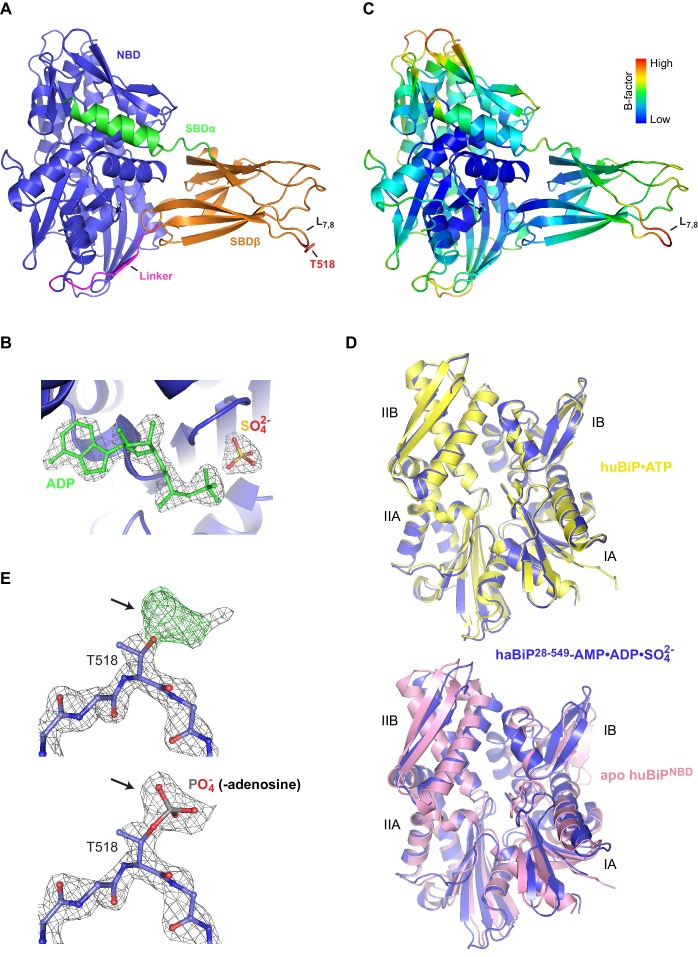
Crystal structure of ADP-bound AMPylated BiP.(A) Ribbon representation (side view) of the structure of haBiP28-549 crystallized in presence of ADP (PDB 6EOF). The nucleotide binding domain (blue; NBD), interdomain linker (magenta; Linker), substrate binding subdomain β (orange; SBDβ), substrate binding subdomain α (green; SBDα), loop L7,8, and the AMPylation site residue (red; T518) are indicated. (B) Close-up view of the nucleotide binding cleft of the NBD shown in ‘A’ (blue). The density map (2Fo-Fc contoured at 1.00 RMSD; grey mesh) of bound ADP (green) and sulfate are indicated. (C) The structure shown in ‘A’ colored according to Cα B-factors (generated with PyMOL). Note that the highest B-factor values are observed at loop L7,8. (D) Comparison of the NBD of ADP-bound AMPylated haBiP28-549 (PDB 6EOF; blue) and either the structure of the ATP-bound NBD of full-length human BiP (PDB 5E84; yellow) or the isolated apo NBD (PDB 3LDN; pink). The subdomains (A and B) of lobes I and II are indicated. Note that close match between the NBD conformations of ADP-bound AMPylated haBiP28-549 and ATP-bound BiP (Cα alignment RMS = 0.378 Å; residues 1–407; over 305 Cα’s). Also note the widened nucleotide binding cleft of the apo NBD relative to the ADP-bound NBD of AMPylated haBiP28-549 (Cα alignment RMS = 2.911 Å; residues 1–407; over 345 Cα’s). (E) The density map (2Fo-Fc contoured at 1.00 RMSD; grey mesh) and positive difference map (Fo-Fc contoured at 3.00 RMSD; green mesh) of part of the SBD loop L7,8 from the structure of ADP-bound AMPylated haBiP28-549 (PDB 6EOF) with modeled residues is shown before (top) and after (bottom) modeling of a phosphate group (representing part of the phosphodiester bond to adenosine) into the additional density protruding from the T518 side chain (arrows). Oxygen atoms are represented in red and nitrogen atoms in dark blue.